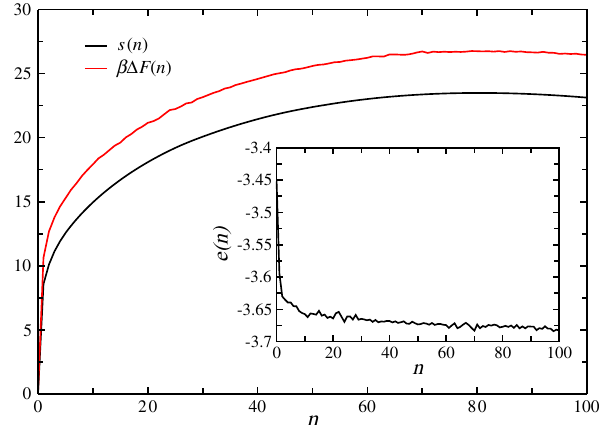
FIG. 13. Free-energy barrier ( β Δ F ) and its entropic contribu- tion ( s ) as a function of nucleus size n for λ ¼ 23 . 15 . The inset shows the size n dependence of the energy per particle e ð n Þ ¼ E ð n Þ =N